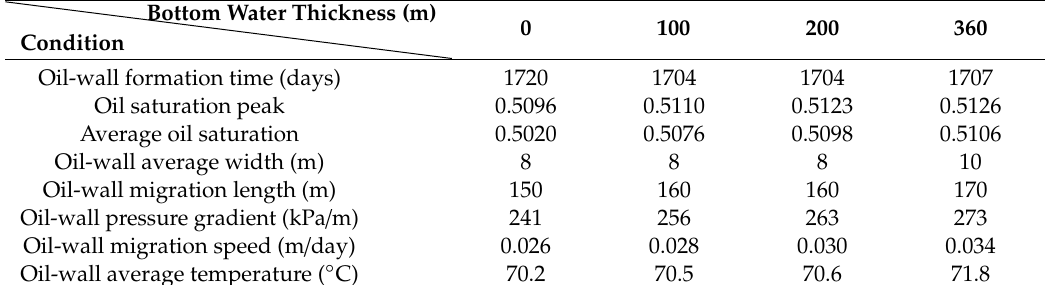
Table 12. Characteristic parameters of oil-wall under di ff erent bottom water thickness.